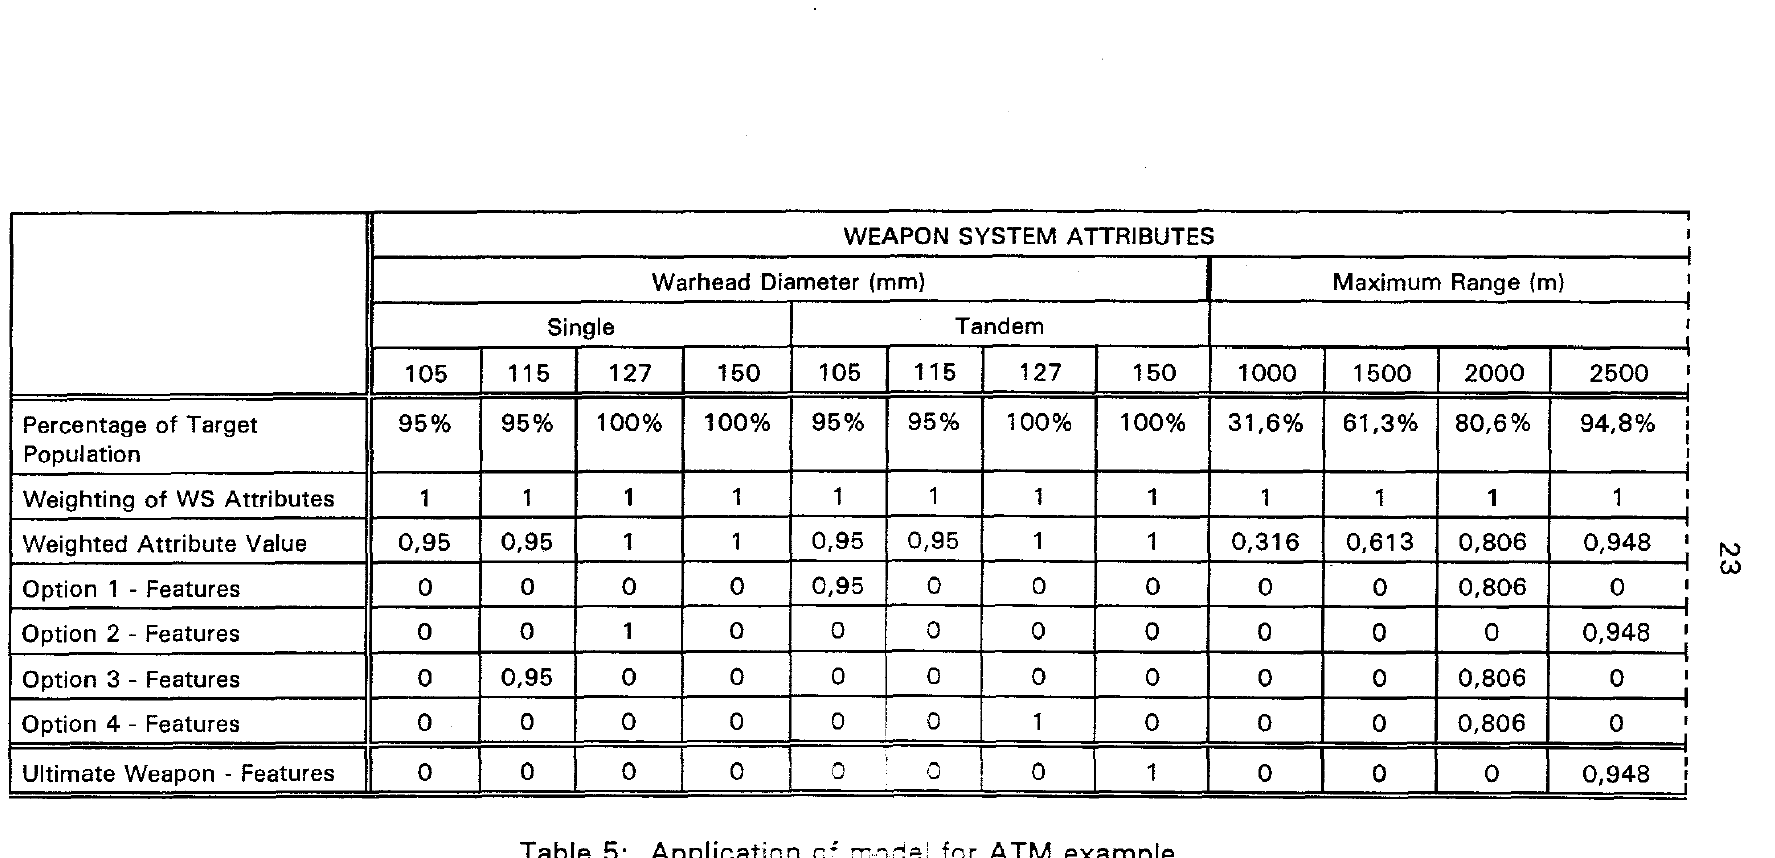
Table 5: Application c~ T·Jde! for ATM